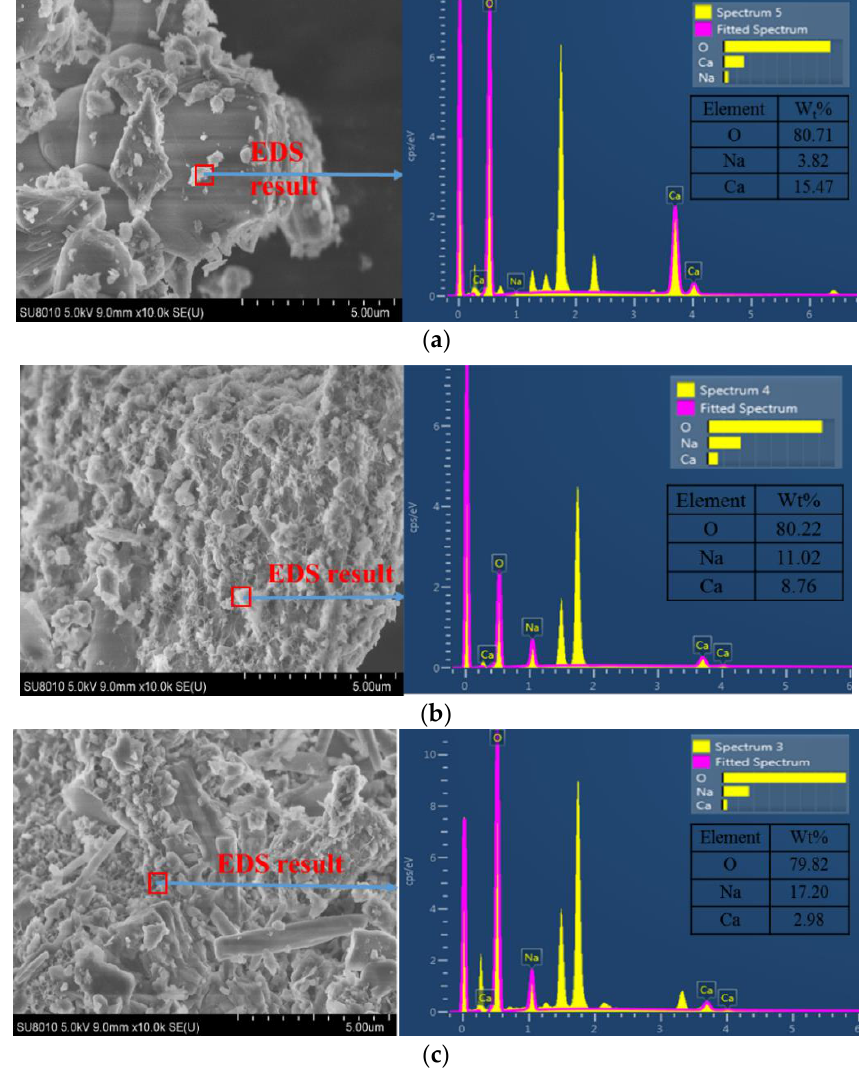
Figure 13. SEM images and corresponding energy-dispersive spectroscopy (EDS) results of specimens with different Sodium sulfate content. ( a ) Cement: 3%, sodium sulfate: 0%, temperature: 10 °C. ( b ) Cement: 3%, sodium sulfate: 1%, temperature: 10 °C. ( c ) Cement: 3%, sodium sulfate: 3%, temperature: 10 °C.